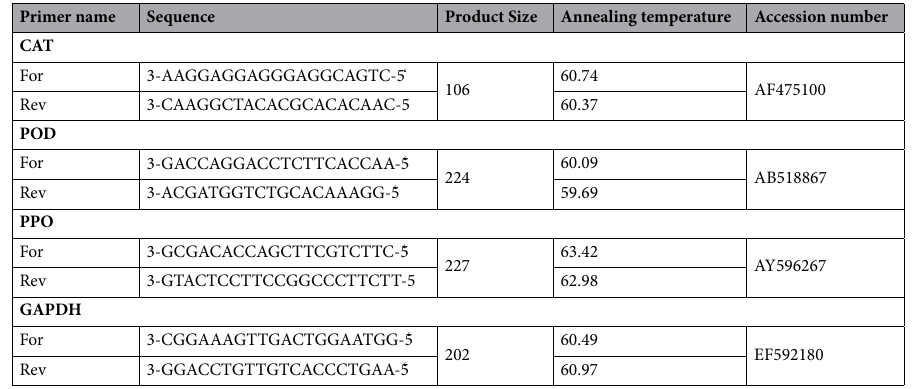
Table 3. Primer sequences used in quantitative real time PCR. CAT catalase, POD peroxidase, PPO polyphenol oxidase, GAPDH glyceraldeyde-3-phosphate